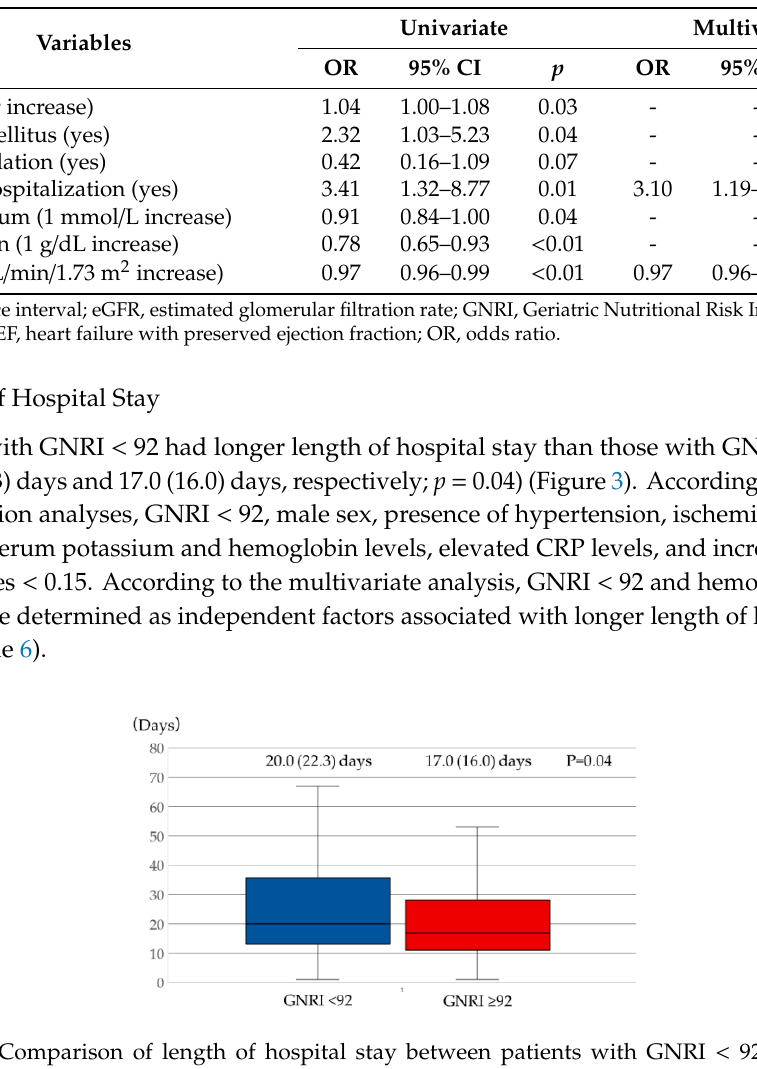
Table 5. Univariate and multivariate analyses of factors associated with increased in-hospital mortality in HFpEF.